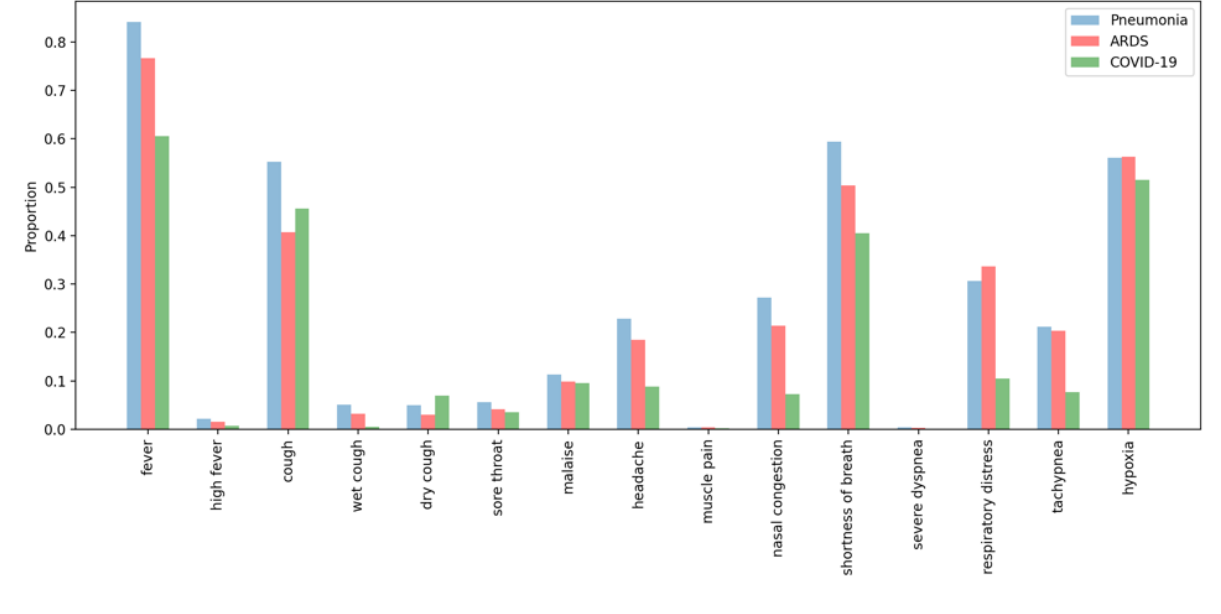
Figure 10. The proportion of patients with each COVID-19 clinical feature documented within their discharge summary according to disorders (pneumonia, ARDS, and COVID-19). ARDS: acute respiratory distress